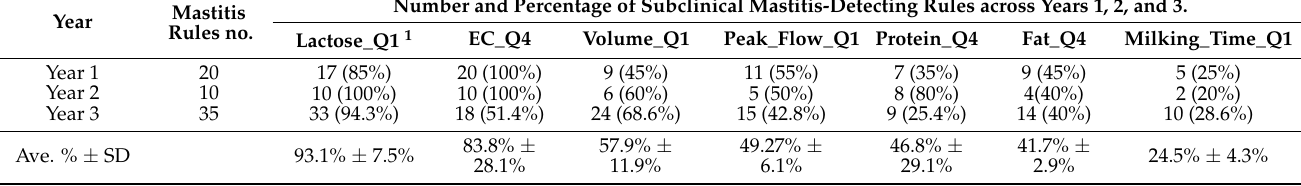
Table 2. Quartiles of milking features that repeat in rules of subclinical mastitis classification (over-represented quartiles) over multiple years.